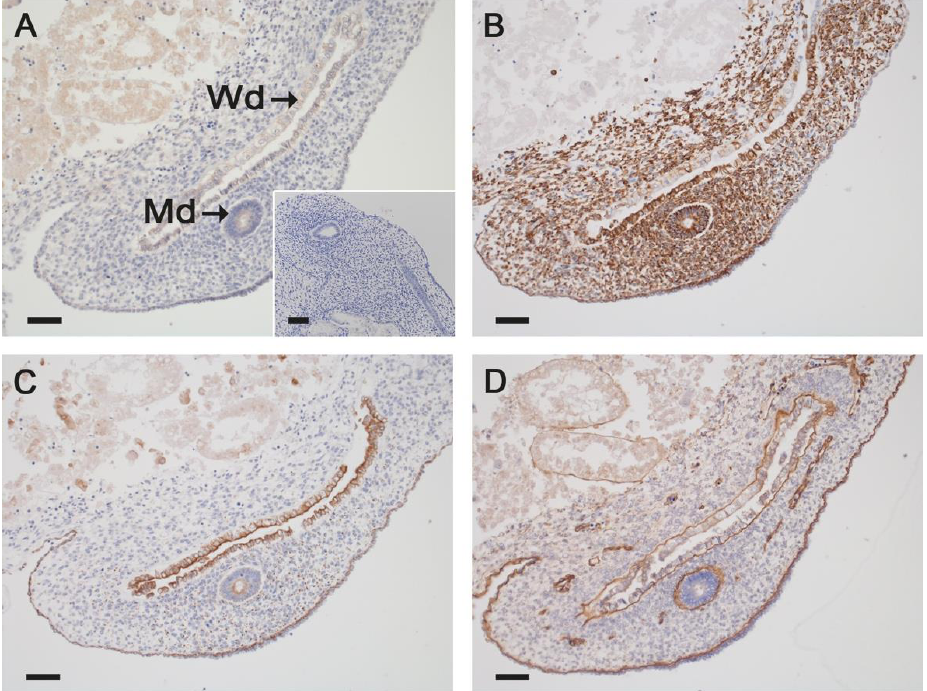
Figure 6. Immunostaining for ß-catenin ( A ), pan-cytokeratin ( B ), vimentin ( C ) and laminin ( D ) in Wolffian (Wd) and Müllerian (Md) ducts. Representative images from a 60-day-old female horse fetus are presented. Both ducts were positive for ß-catenin and vimentin irrespective of fetal sex ( A , B ). While the mesonephric ducts consistently stained positive for cytokeratin in all samples, in the paramesonephric ducts the staining ranged from only apical cytoplasmic staining to an entirely positive cytoplasm ( C ). Both ducts presented a well-developed basal lamina in both sexes ( D ). Scale bar for all pictures: 50 µm.